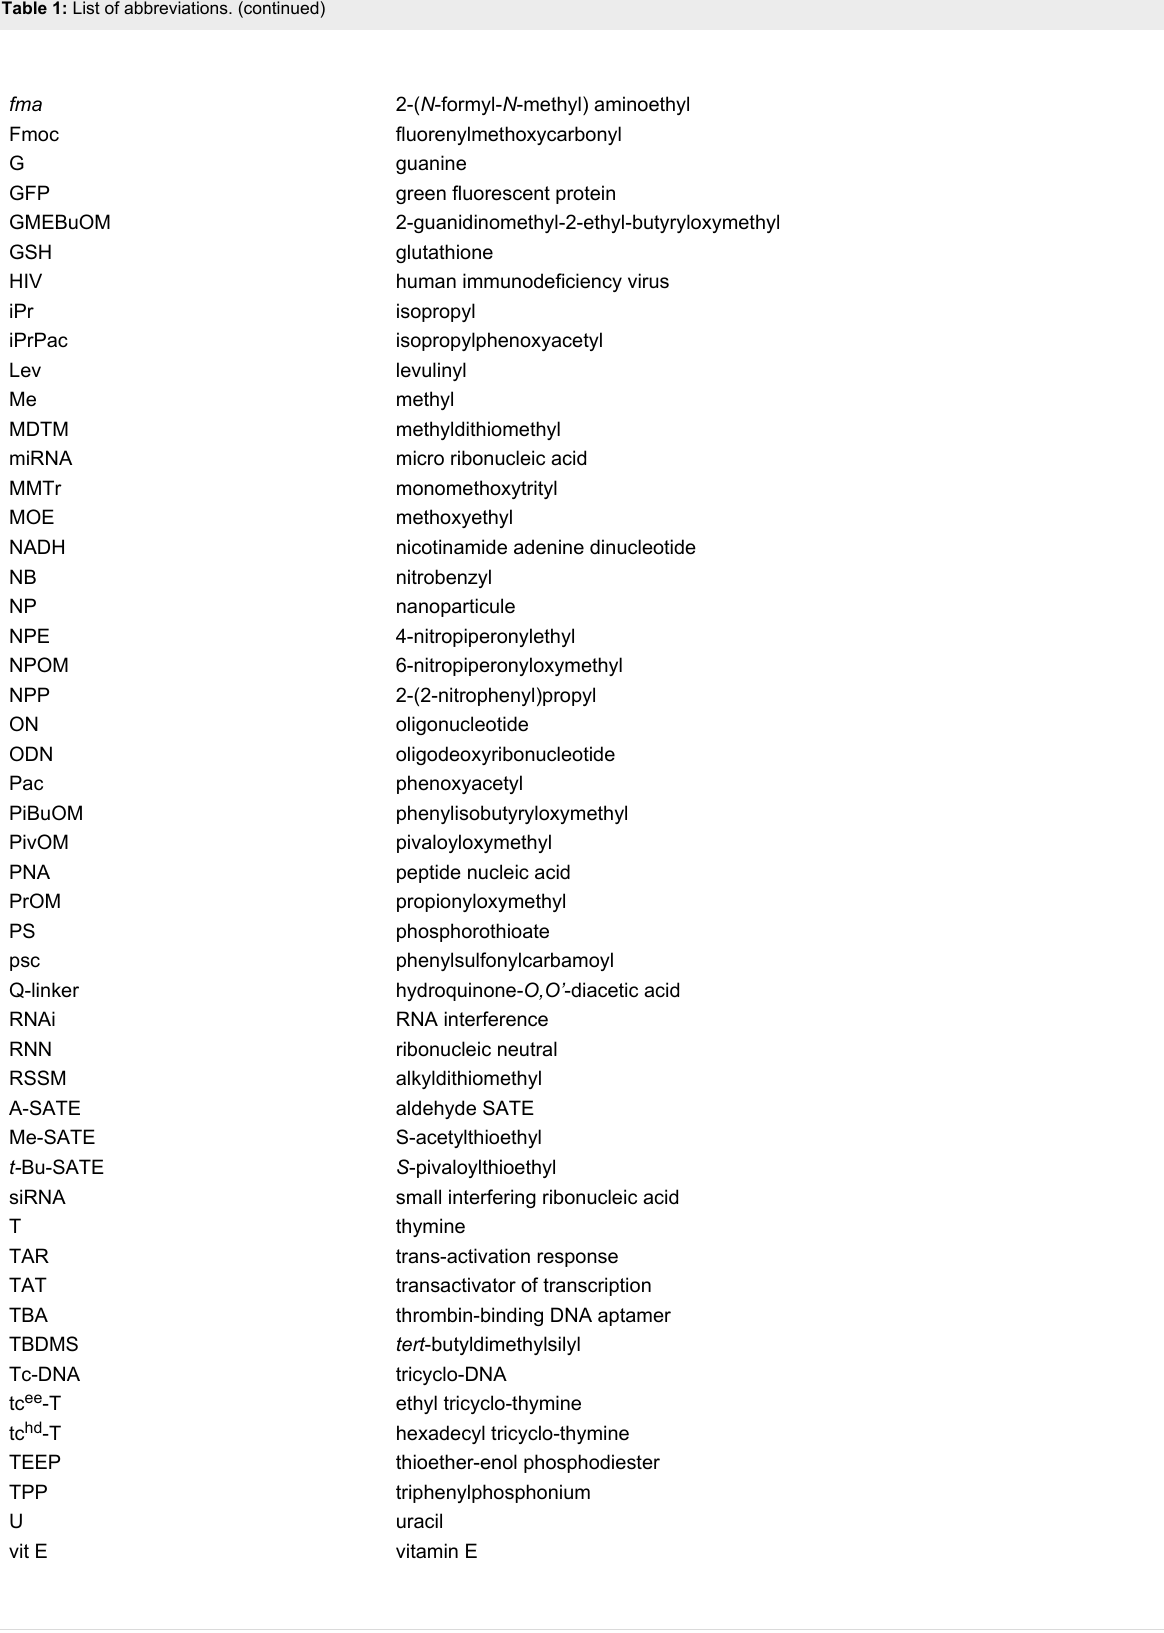
Table 1: List of abbreviations. (continued)